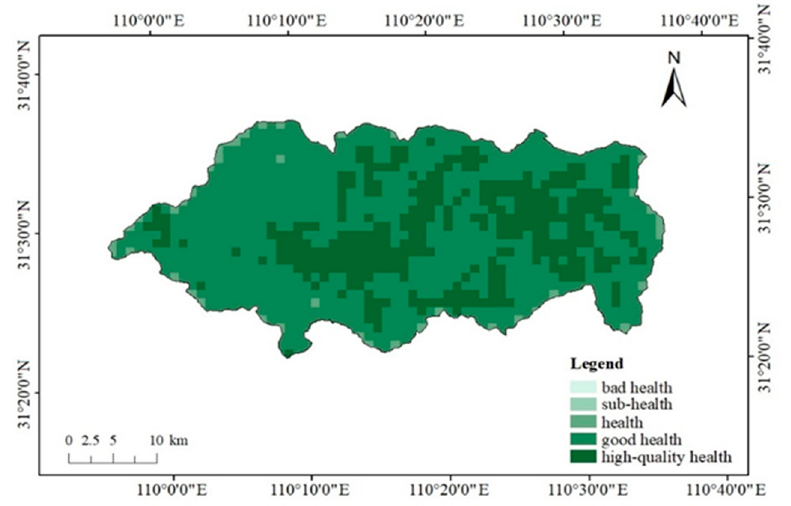
Figure 2. Ecosystem health level in Shennongjia National Park.